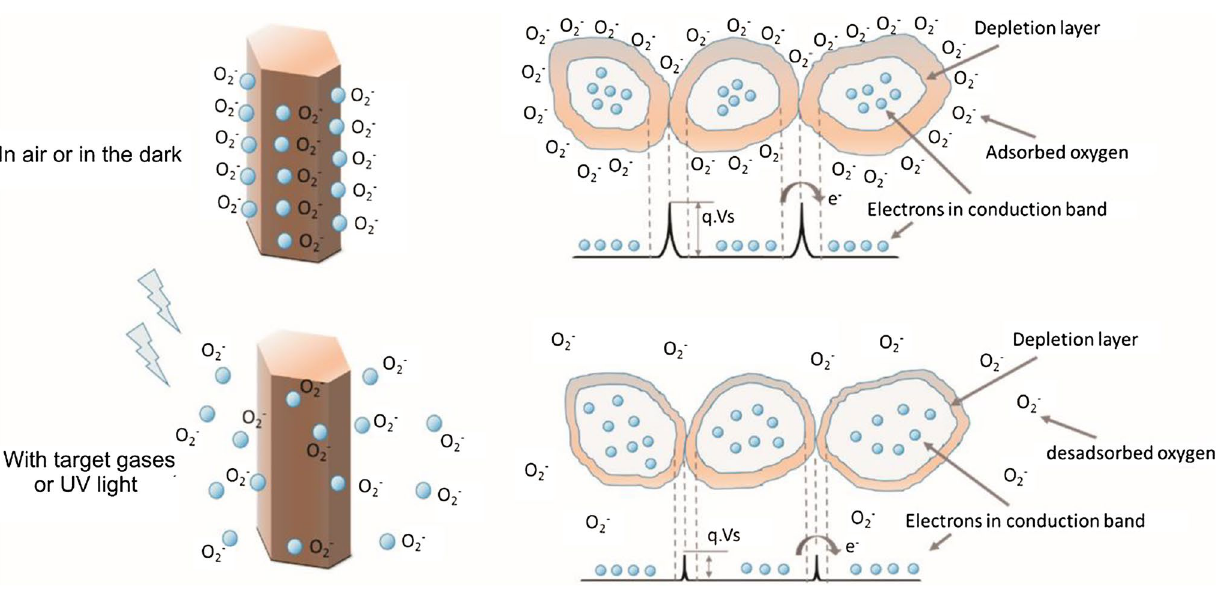
Fig. 1 A n -type semiconductor sensing mechanism (structural and band model) in the presence of target gases or UV irradiation. The barrier height is identified as ( q.V ). Reproduced from [52] with permission of S